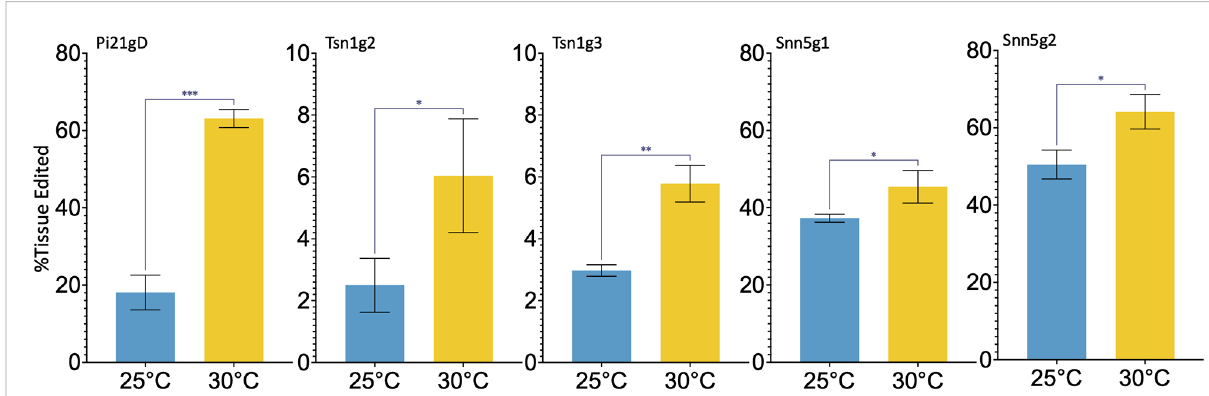
FIGURE 1 Targeted editing ef fi ciency of gRNA-Cas9 ribonucleoproteins with different temperature treatments in wheat protoplasts. Five gRNAs, Pi21gD, Tsn1g2, Tsn1g3, Snn5g1, and Snn5g2 were tested and transfected independently into protoplasts. N=3. P-values from left to right are, p=0.0001, p=0.0393, p=0.0015, p=0.0152, p=0.0319. A p-value less than 0.05 is fl agged with one star (*), less than 0.01 is fl agged with 2 stars (**), and less than 0.001 is fl agged with three stars (***). Error bars indicate